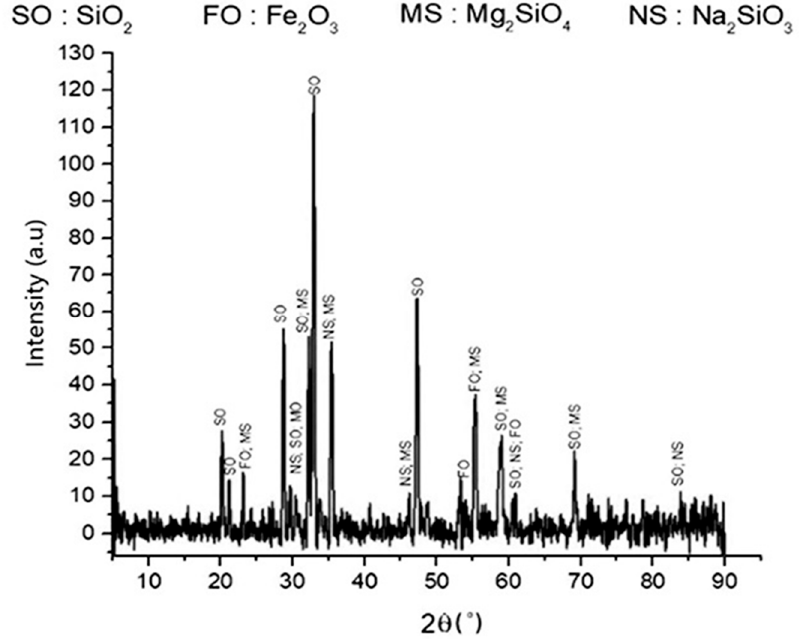
Figure 1. XRD pattern of roasted product. The roasted product consisted of silica, hematite, forsterite, and sodium silicate. Table 1. Chemical composition of roasted slag, measured by